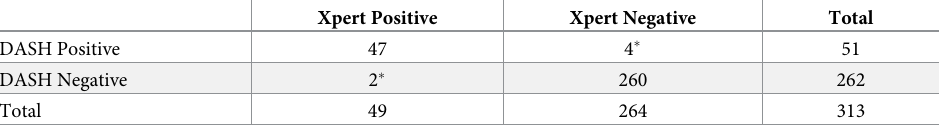
Table 2. Summary of Diagnostic Analyzer for Selective Hybridization (DASH) PCR results compared to Cepheid Xpert Xpress (Xpert) PCR